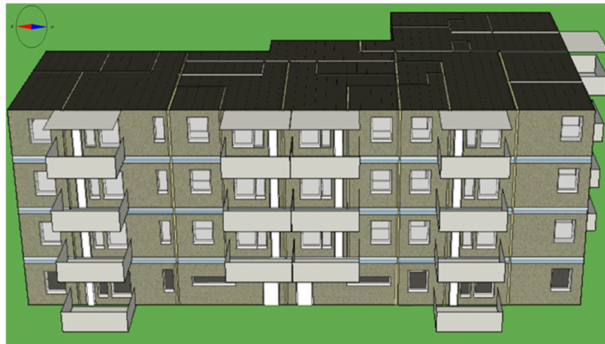
Figure 1. The geometry of the building.